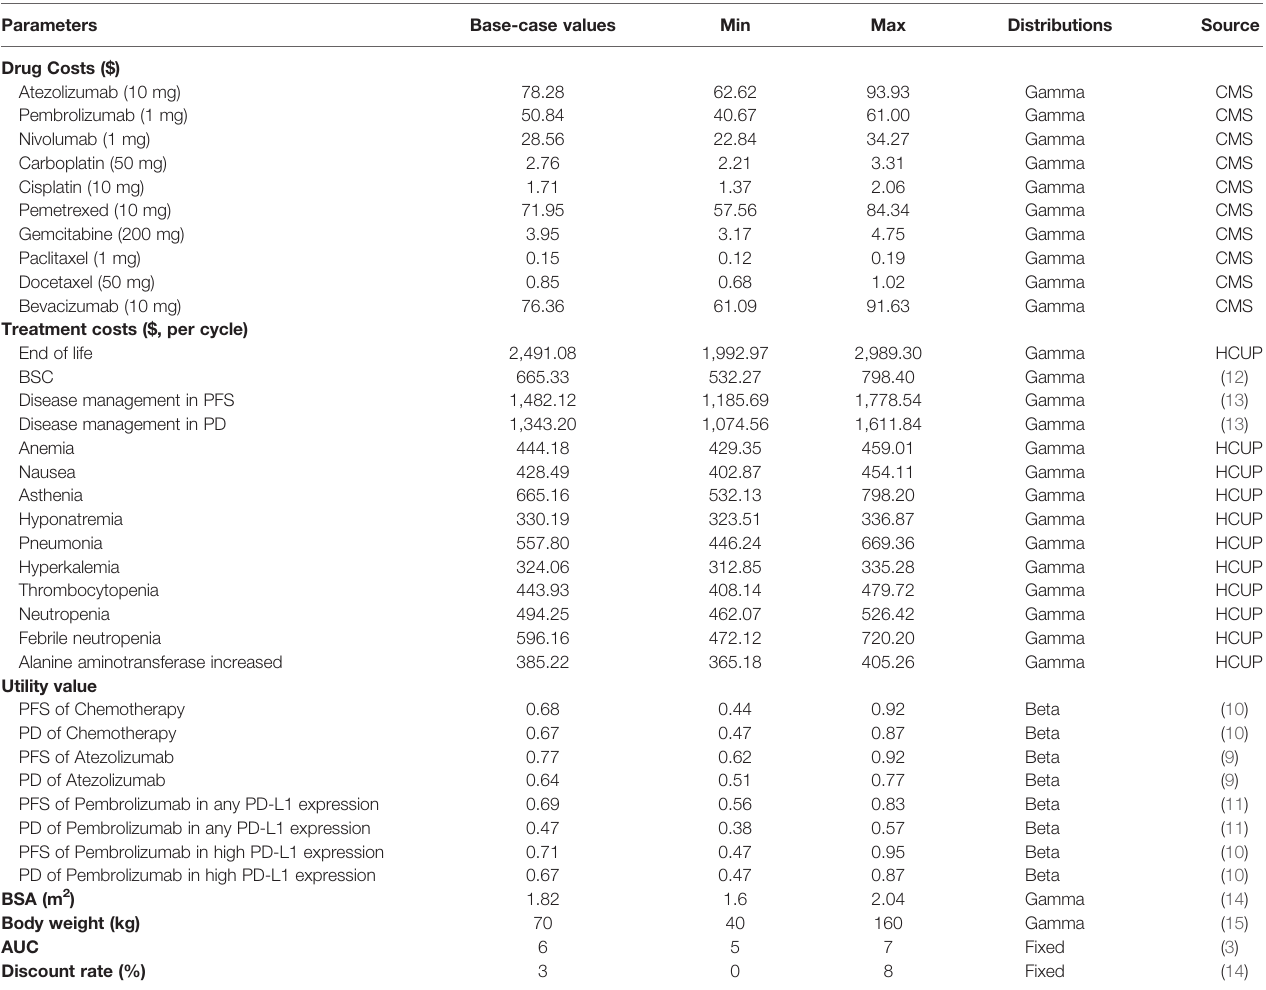
TABLE 1 | Ranges and distributions of parameters used in sensitivity analyses.